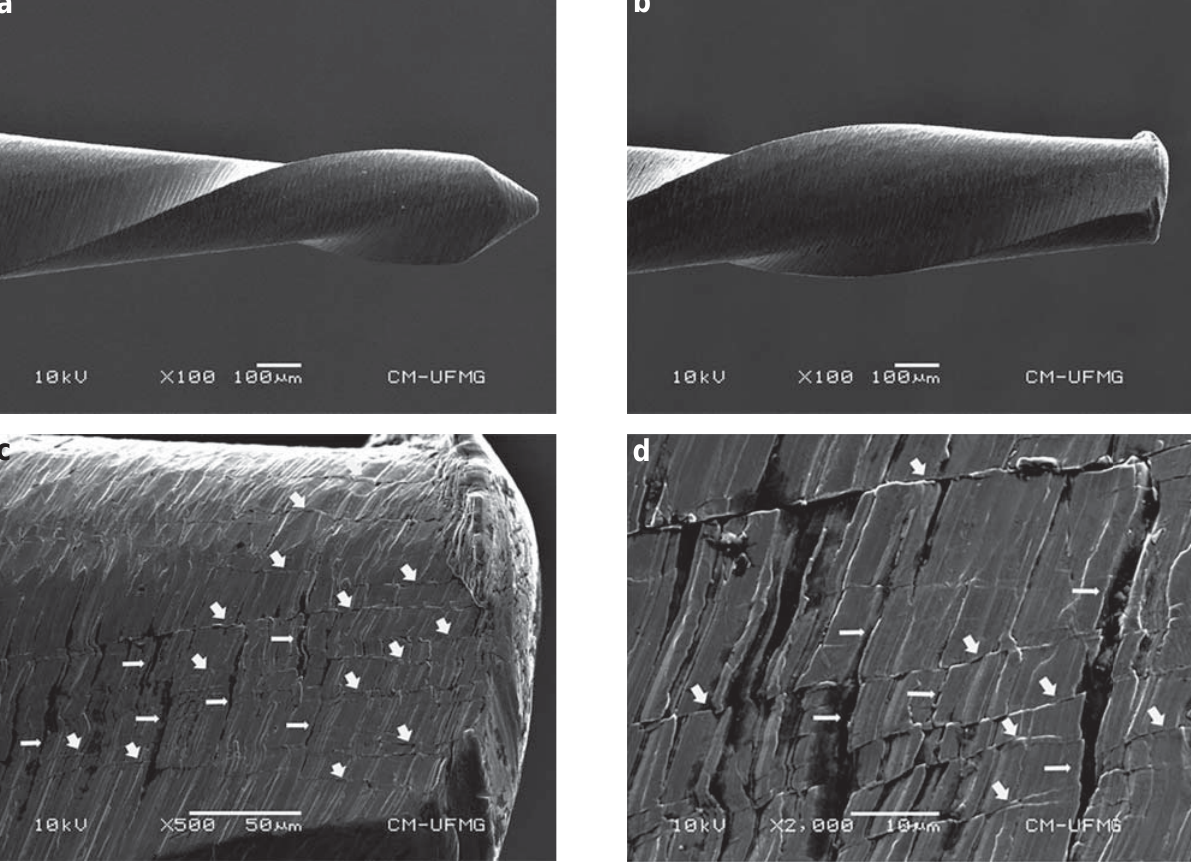
Figure 4- Secondary electron images obtained by scanning electron microscopy. New Reciproc (a) and fractured Reciproc after clinical use (b). Presence of high concentration of typical longitudinal/parallel (wide arrows) and transverse (thin arrows) microcracks on the surface of a RC instrument fractured during clinical use (c,